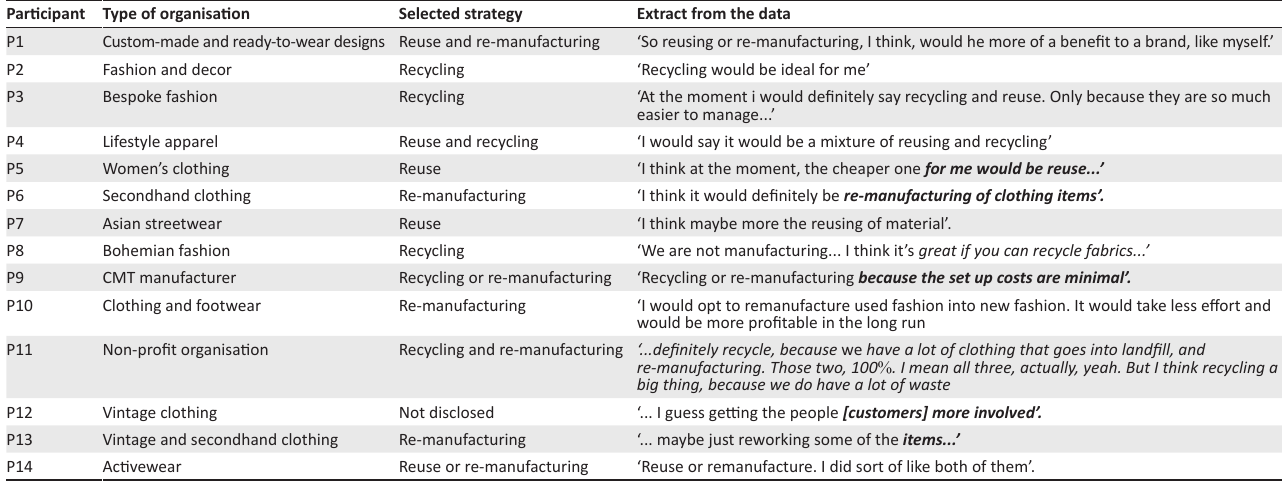
TABLE 3: Closed-loop supply chain strategies that are most suitable for small, medium and micro enterprises in South Africa. Participant Type of organisation Selected strategy Extract from the